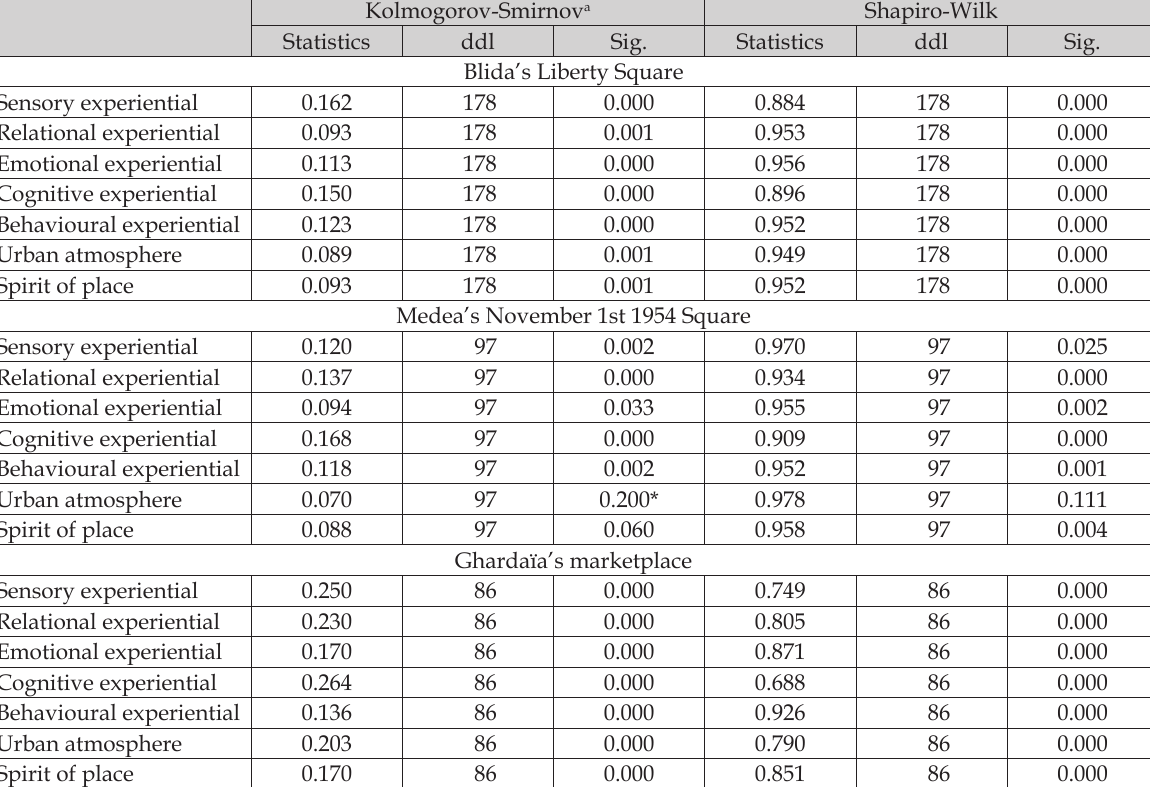
Table 3. Tests of normality of the experiential variables of public